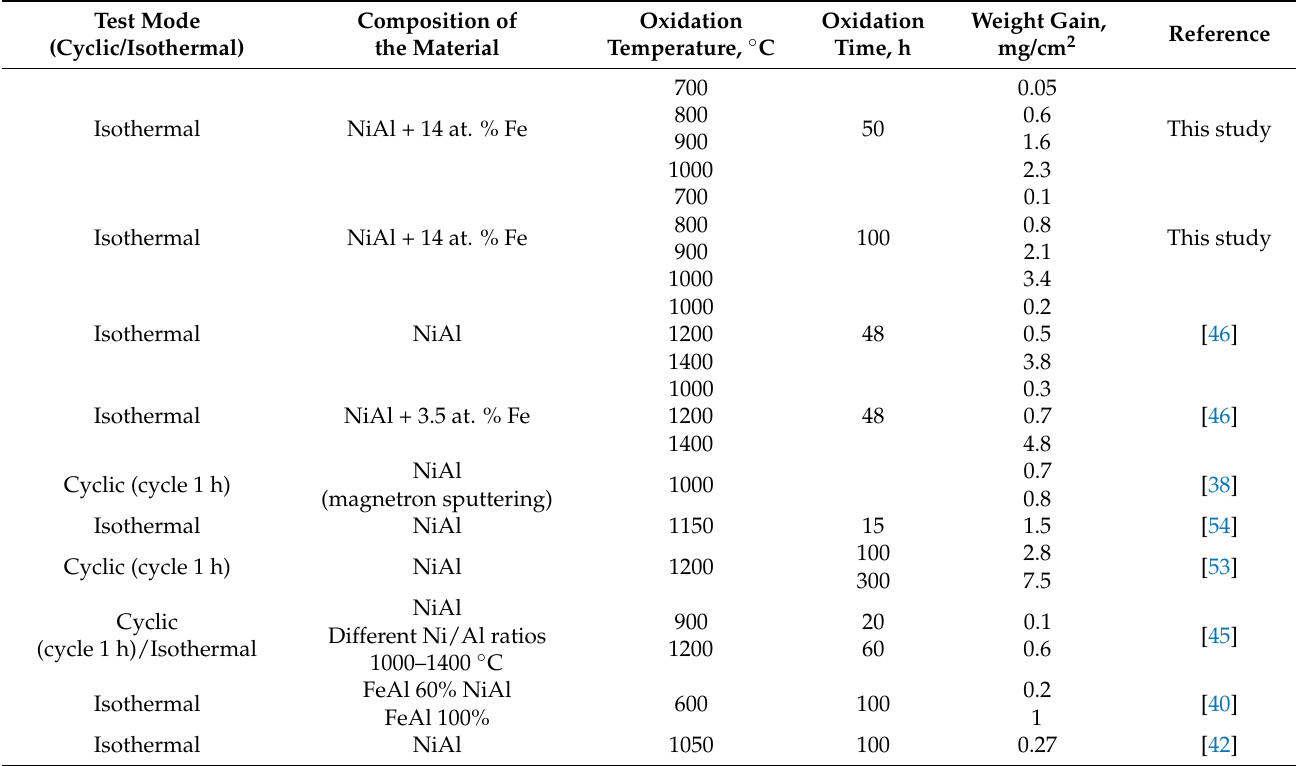
Table 6. Comparison of weight gain results with results from other